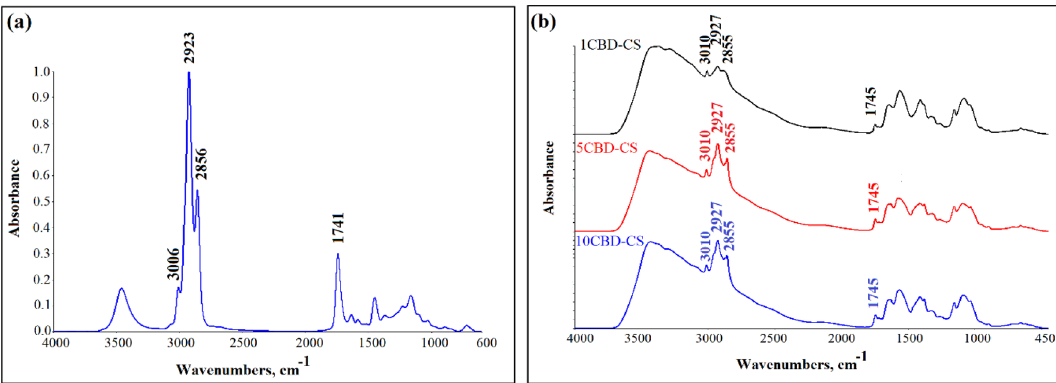
Figure 1. FTIR spectrum of the ( a ) cannabis oil and ( b ) CBD-CS films; cannabidiol-chitosan-based films (CBD-CS), where 1, 5, 10CBD-CS corresponds to the weight ratio of 1, 5 or 10% of cannabidiol oil (CBD) to chitosan